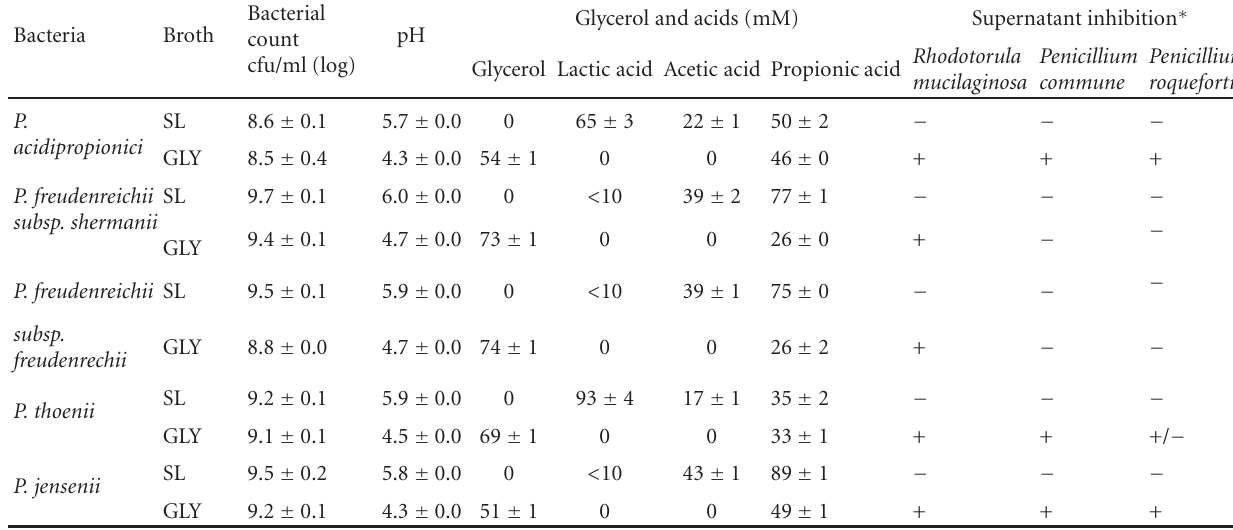
Table 2: Results from analysis of cultured broth after 72h of incubation with 5 di ff erent type strains of propionibacteria. Results include bacterial counts, pH, glycerol, acids, and inhibition against three di ff erent spoilage fungi in a microtitre plate assay. Data in the table show mean values with one standard deviation ( n = 4).